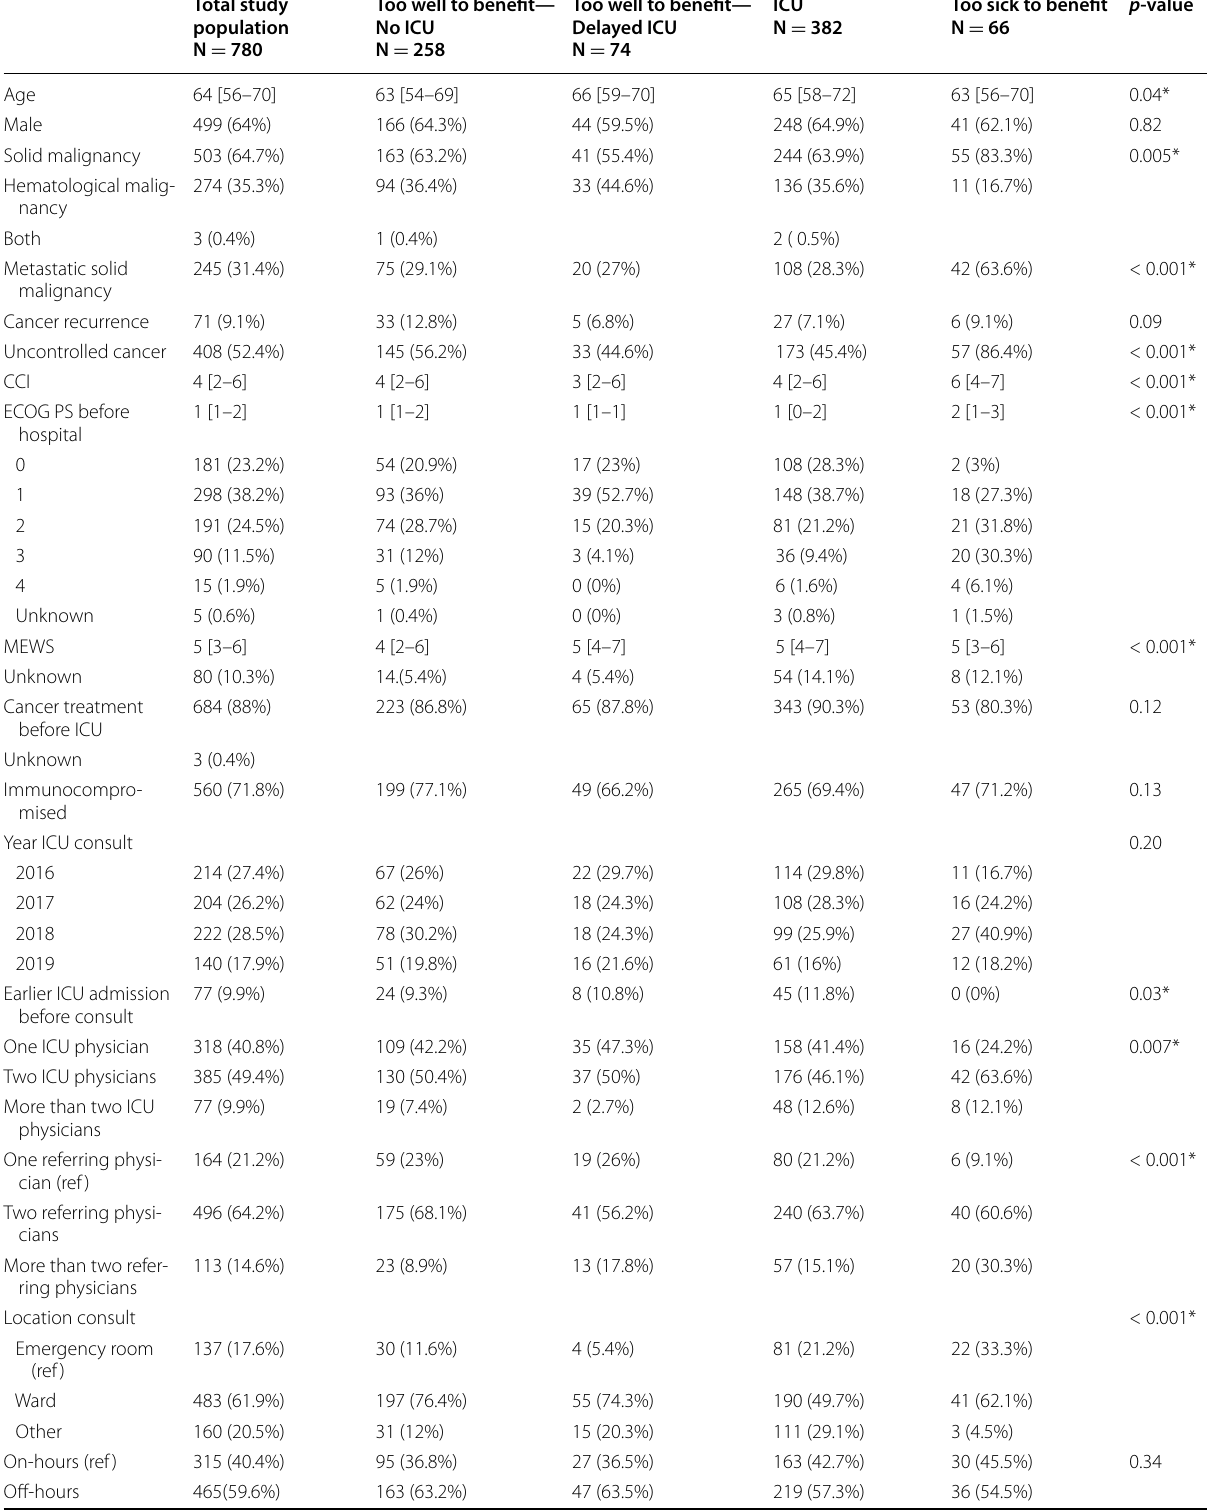
Table 1 Baseline characteristics by ICU triage